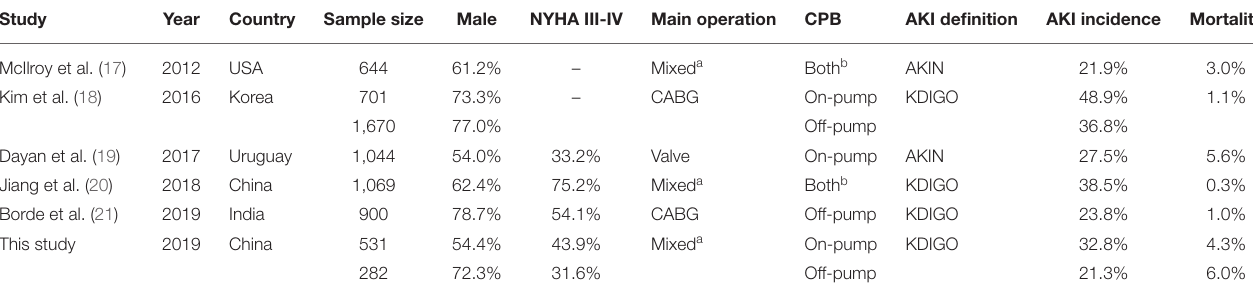
TABLE 4 | Main characteristics of all studies included in the meta-analysis.